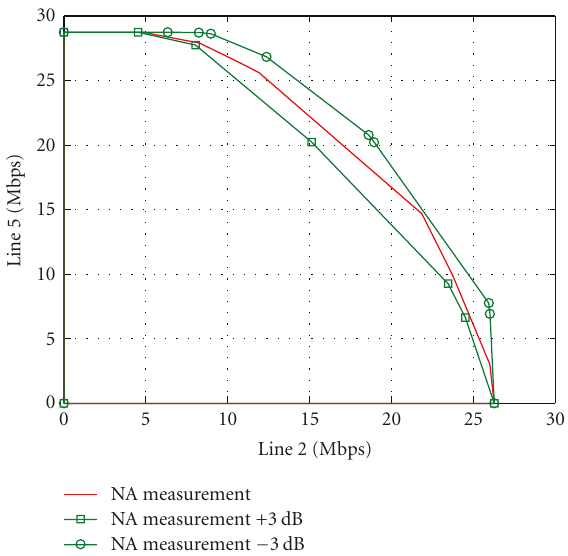
Figure 13: Total data throughput for the 10 users Scenario II using the SCALE algorithm, comprising approximately 100